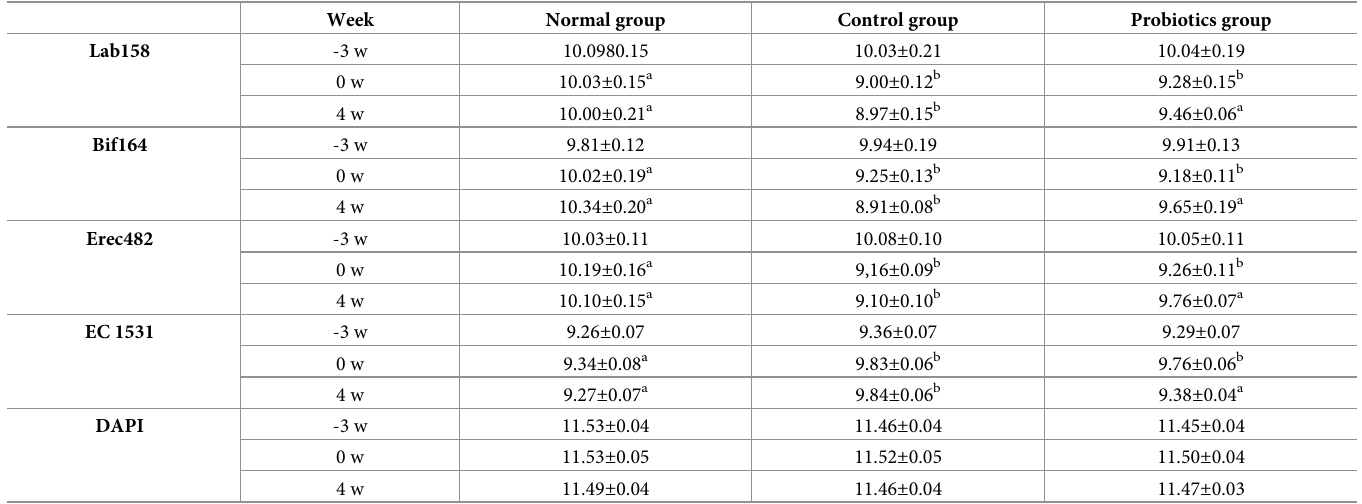
Table 10. The effect of probiotics treatment on microbiological analyses of faeces (log cells/g) in adenine-induced CKD rats.